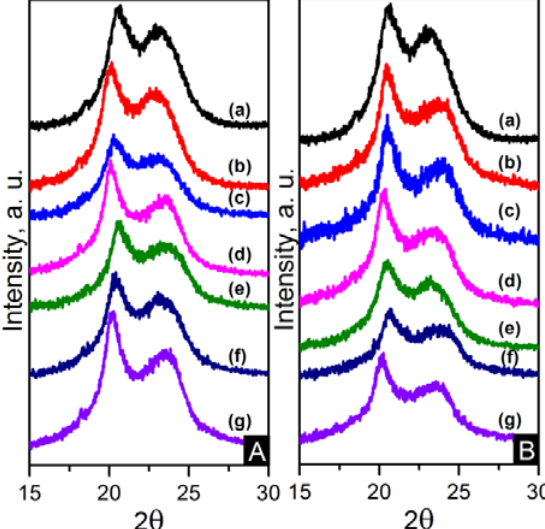
Figure 12. ( A ) WAXD patterns of: ( a ) pure PA66; ( b ) PA66/01CNTs; ( c )